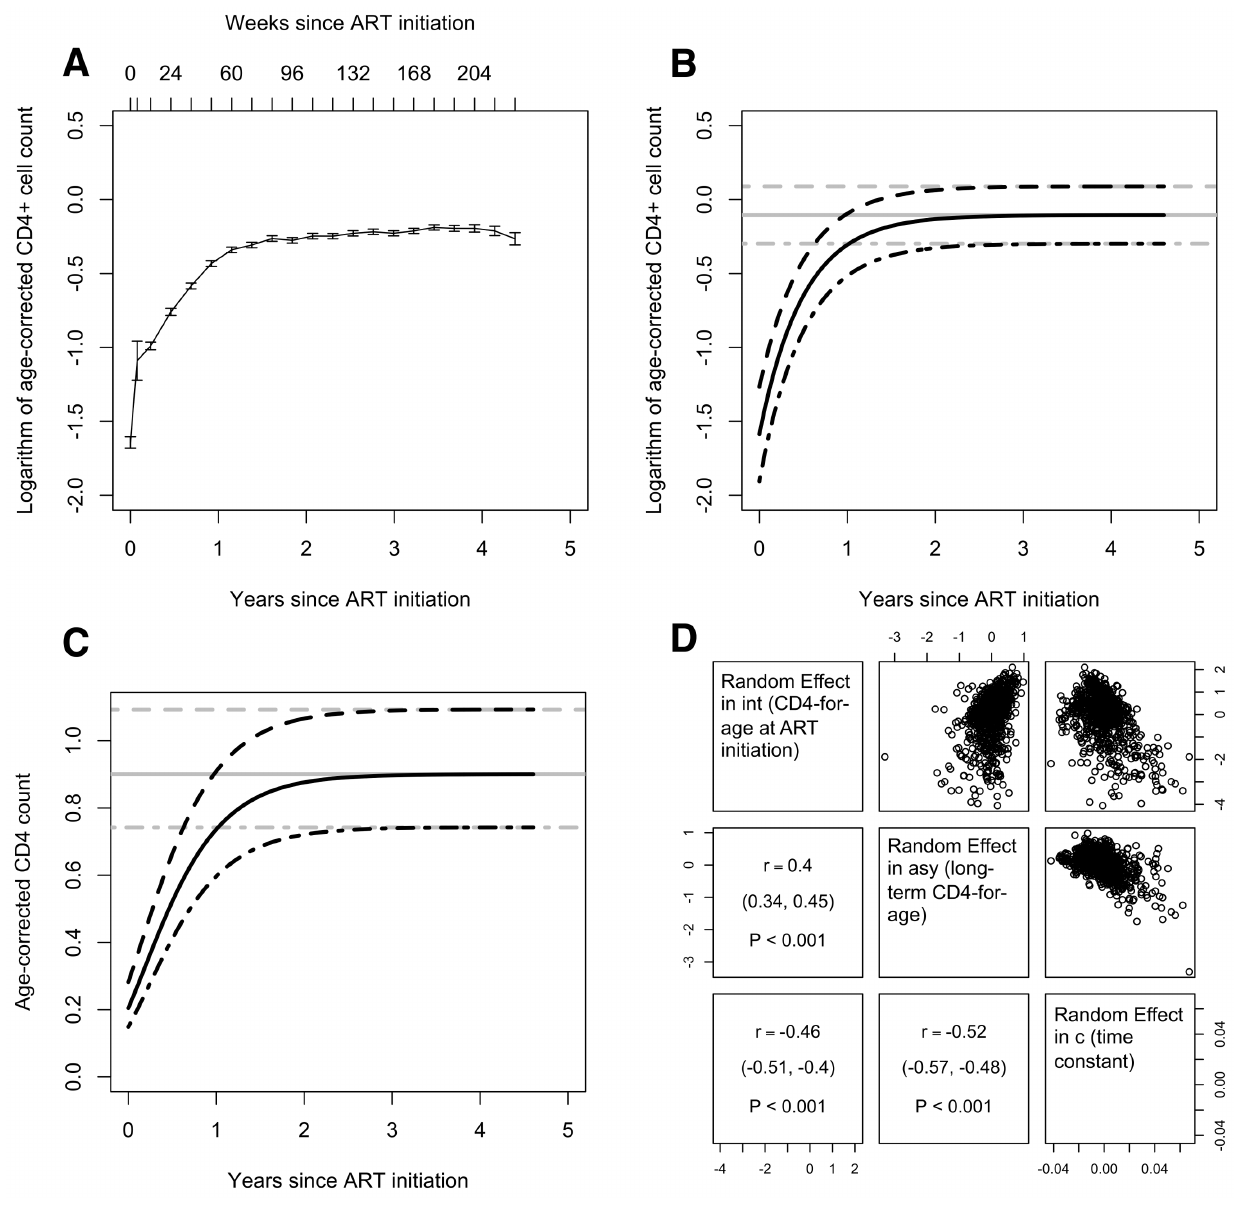
Figure 2. Modelling CD4-for-age in children showing asymptotic reconstitution. (A) Mean CD4-for-age over time since ART initiation for 914 children with asymptotic CD4 reconstitution. Errors bars give standard error of the mean. Points are shown for times where . 20% of children in this group remained in the trial. Only children participating in a substudy had measurements available at week 4, accounting for the wider error bar. The numbers of children with measurements available at 0, 4, 12, 24, 36, 48, 60, 72, 84, 96, 108, 120, 132, 144, 156, 168, 180, 192, 204, 216, and 228 wk were 914, 153, 897, 893, 900, 893, 894, 898, 989, 900, 902, 898, 899, 897, 896, 892, 861, 790, 516, 354, and 232, respectively. (B) Population-average (fixed-effects) ln(CD4-for-age) trajectories predicted by our nonlinear mixed-effects model (Table 2) for ‘‘average’’ HIV-infected children (female, weight-for-age z -score at ART initiation 2 2.2) aged 2 (dashed line), 6 (solid line), and 10 (dot-dashed line) y. (C) Predicted CD4-for-age trajectories as shown in (B), but plotted on the linear scale (i.e., CD4/expected CD4). (D) Correlations between child-level random effects (difference from population average) in the three model parameters. Each panel refers to correlations between the estimated random effects (differences between child-specific parameters and the population average) in two of the three parameters int (CD4-for-age at ART initiation), asy (long-term CD4-for-age), and c (proportional recovery rate). The pair of parameters being considered is identified by the row and column labels in the panels on the diagonal. The upper-right panels plot the values of the random effects against one another. The lower-left panels give Pearson correlations between the estimated random effects, with 95% confidence intervals and p -values.